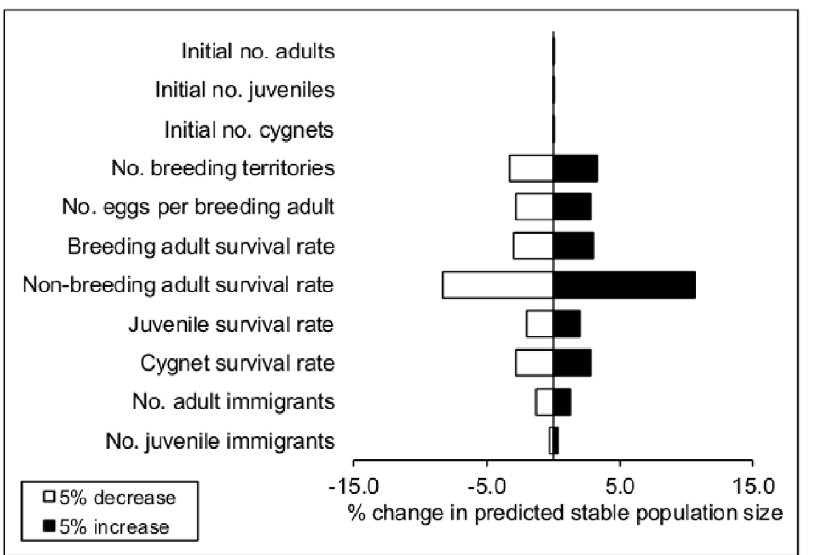
Figure 5. The sensitivity of the stable population size projected by the model to ± 5% changes in the mean value of each parameter. We defined the stable population size as the mean population size between years 36 and 50 of the simulations.